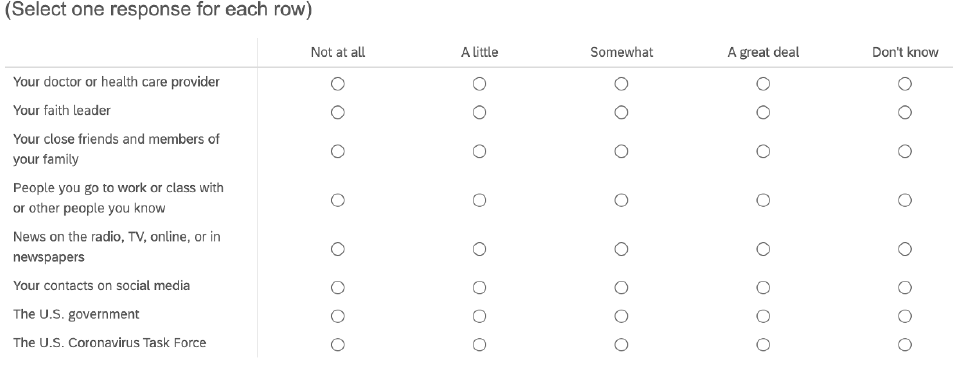
Figure A1. The original question in both of our surveys on trust indexes.